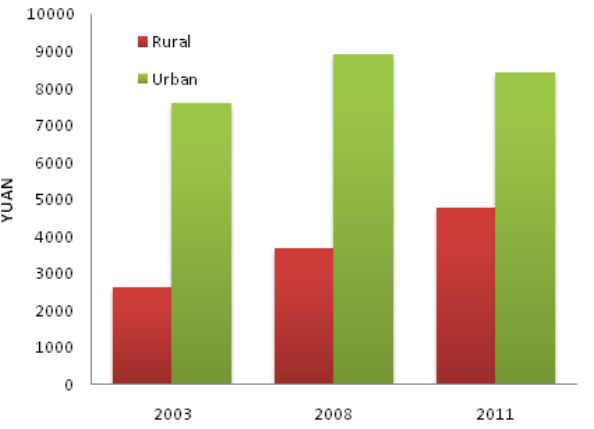
Figure 3 Average cost of an inpatient visit (Yuan) in rural and urban areas, in 2003, 2008, and 2011. Source: ref.